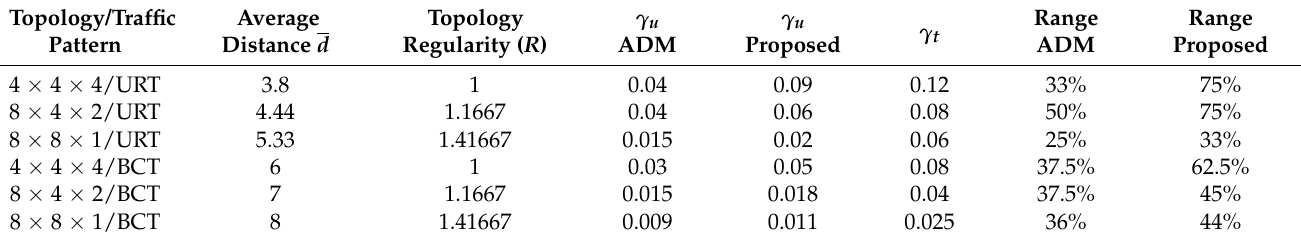
Table 2. Model error